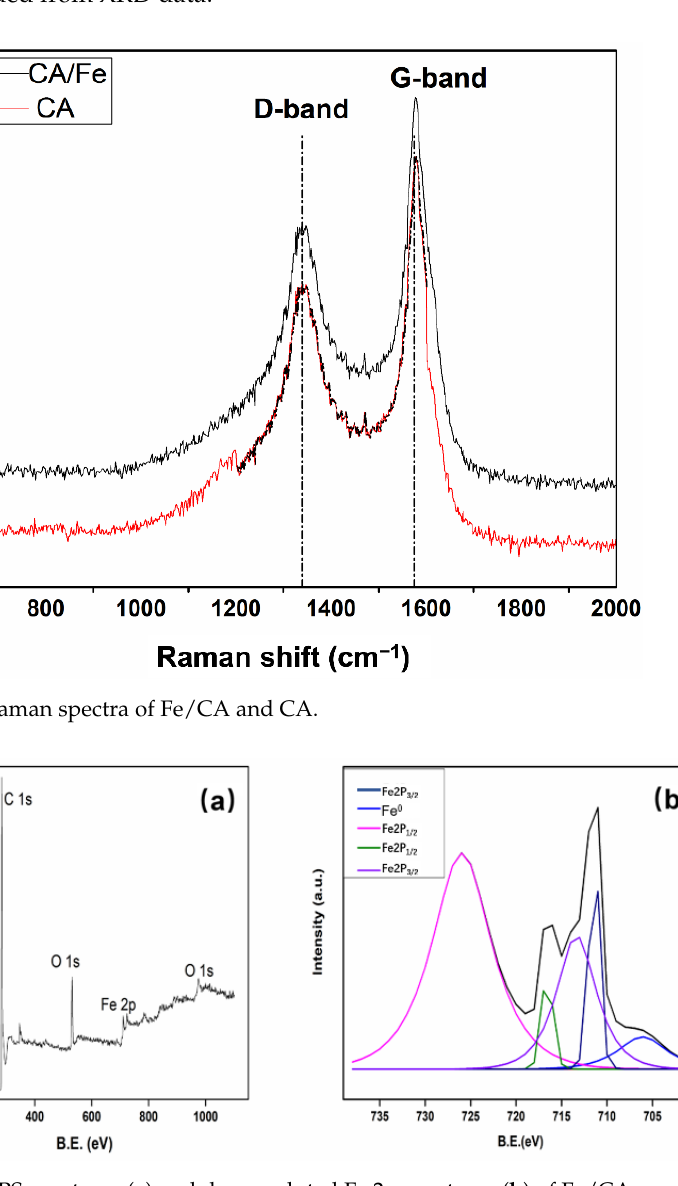
Figure 6. Raman spectra of Fe/CA and CA.